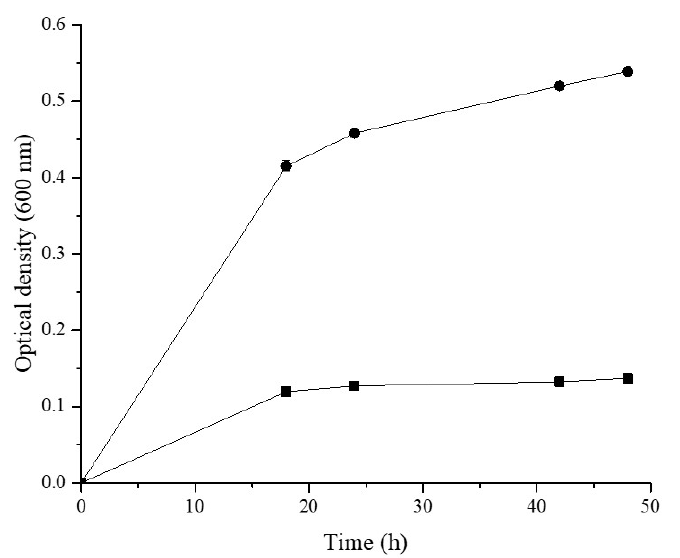
Figure 2. Growth of the bacterial mixture during the fermentation of (●) AX and ( ■ ) Control (no added carbon source).